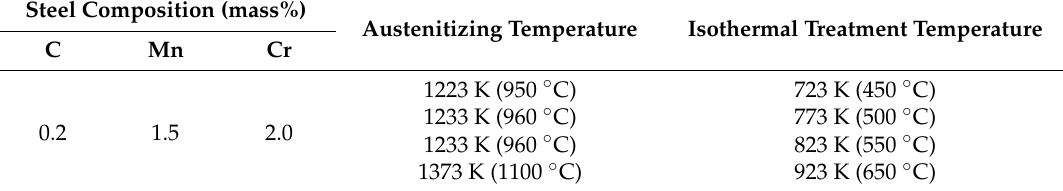
Table 1. Testing matrix containing the details of the alloy composition and thermal treatments applied with in situ optical